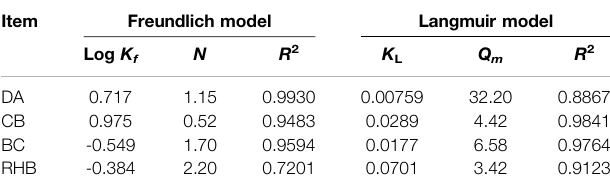
TABLE 1 | Adsorption fi tting parameters of four different tested materials.